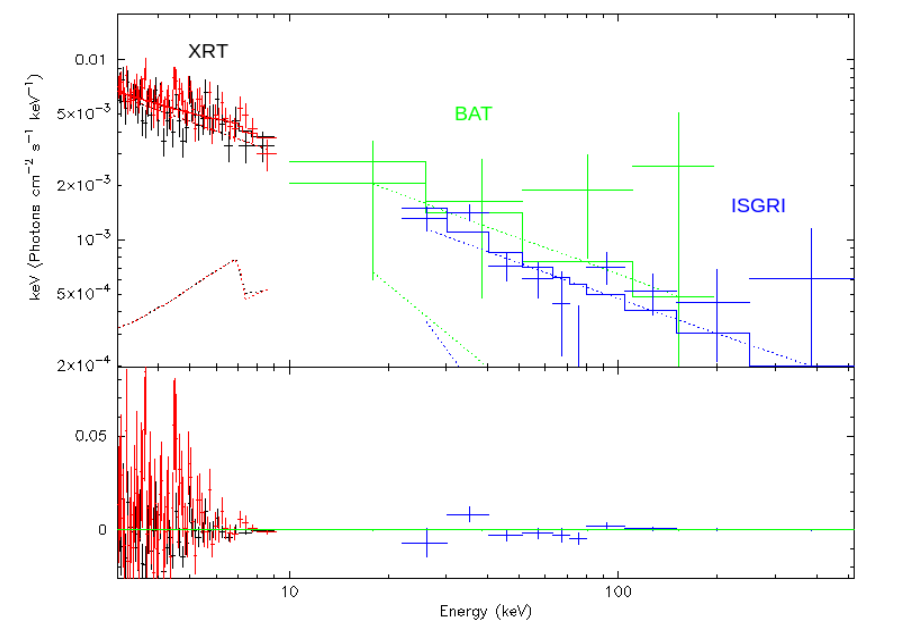
Figure A10. Unfolded SWIFT/XRT, SWIFT/BAT and INTEGRAL/ISGRI spectra of 3C 111 during 10th (January 2013) observational period and model. Above: all the spectra are shown by crosses; fitting curves are shown by solid lines; model components are shown by dotted lines; below: data residuals. During this period jet base emission was dominating significantly over nuclear one (the jet base flux in 5–7 keV range was near six times higher than the nuclear one); emission in Fe-K α line was